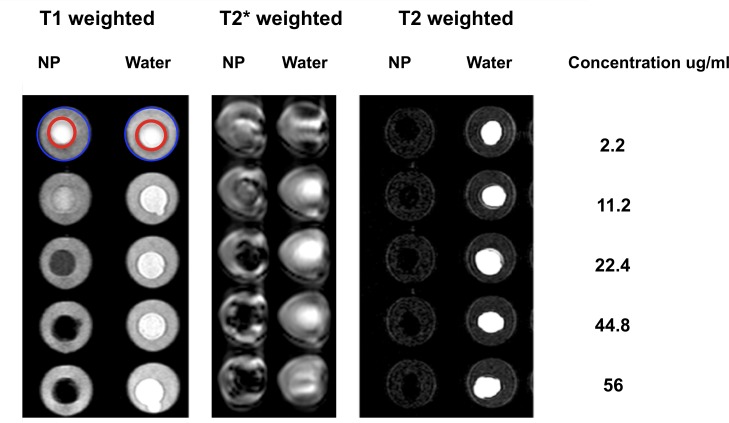
Concentration dependent T1, T2* and T2 weighted MRI signal of nanoparticle solutions and water.MRI signal associated with water or nanoparticle solution (located within the central, red circle) is contrasted against MRI signal of simulated cartilage (located between red and blue circles). Solutions at or above 22.4 μg/mL produced marked hypointense signal on T1, T2 and T2* weighted sequences in contrast to water or simulated cartilage.